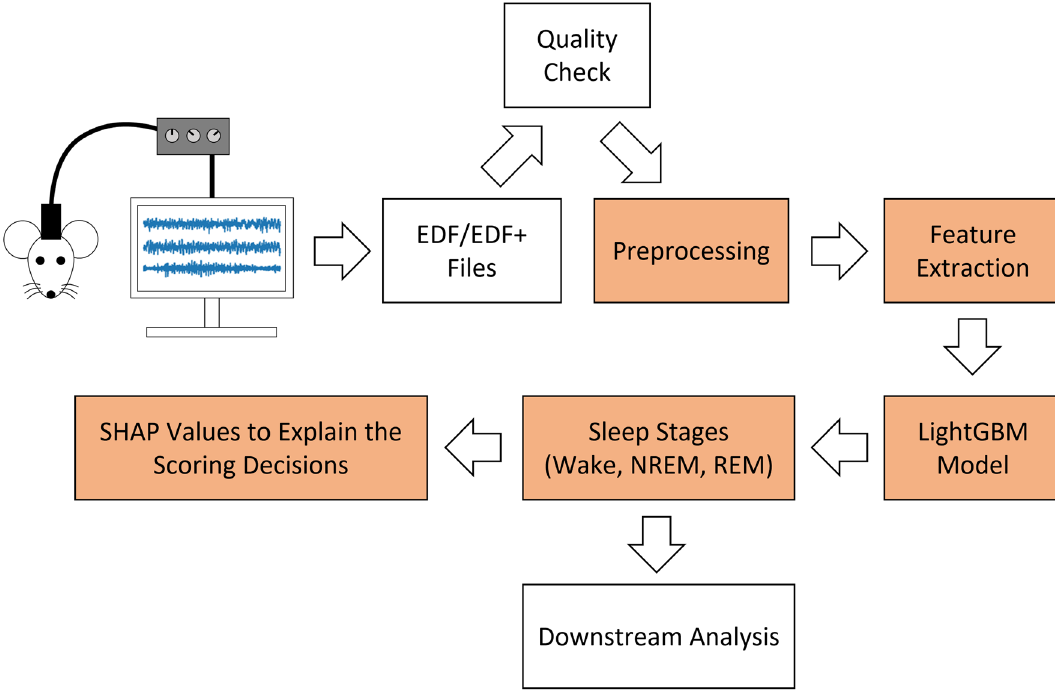
Figure 1. Schematic diagram of the workflow facilitated by IntelliSleepScorer. The highlighted boxes indicate the functionalities provided by